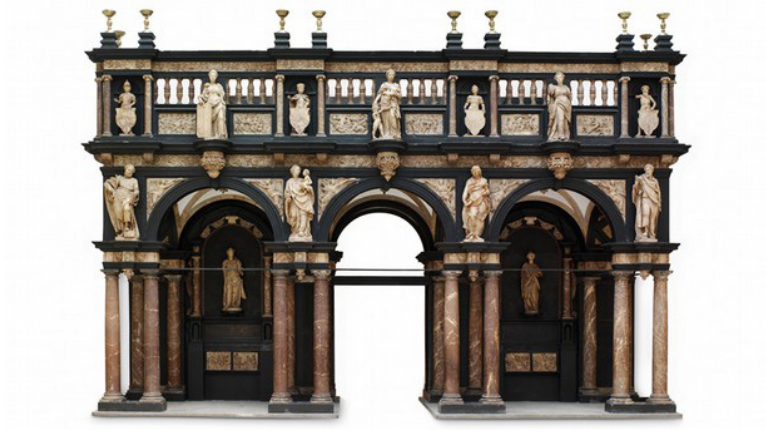
FIgure 3 Carved marble choir screen, by Coenraed van Norenberch, ‘s-Hertogenbosch, Netherlands,